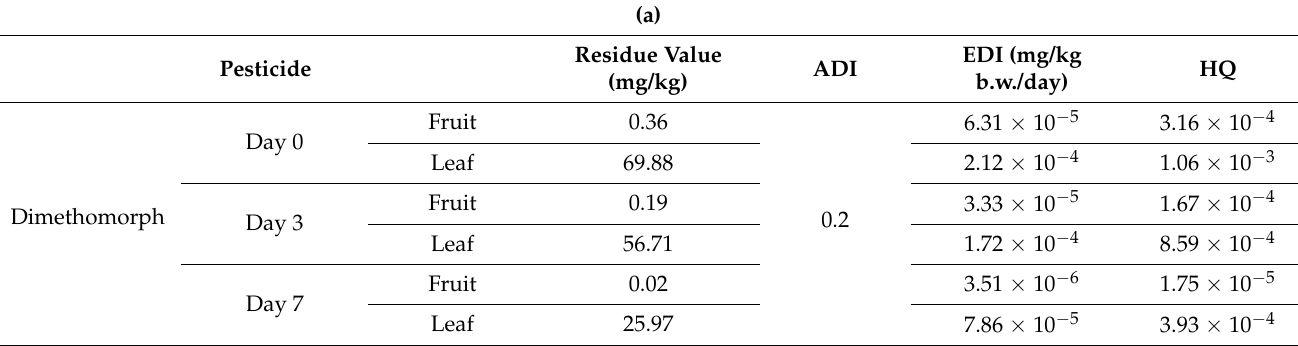
Table 5. ( a ) HQ of four pesticides in total surveyors related to squash fruit and leaf consumption. ( b ) HQ of four pesticides in true consumers related to squash fruit and leaf consumption.